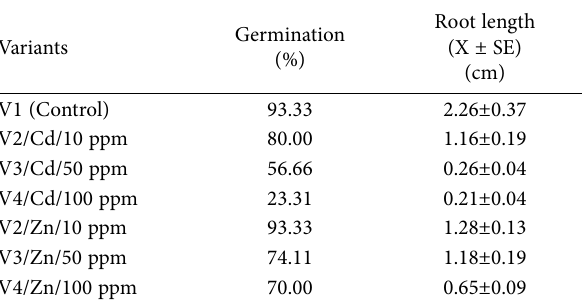
Table 1. Influence of cadmium and zinc on the seeds germination and root length to Ocimum basilicum L.